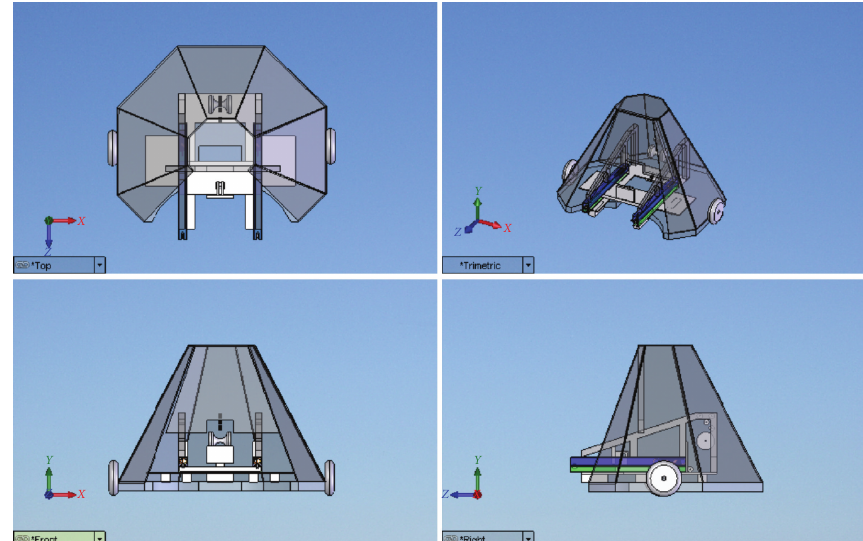
Figure 5: Conceptual design 4: Pyramid of two wheels with a spring-loaded kicker.